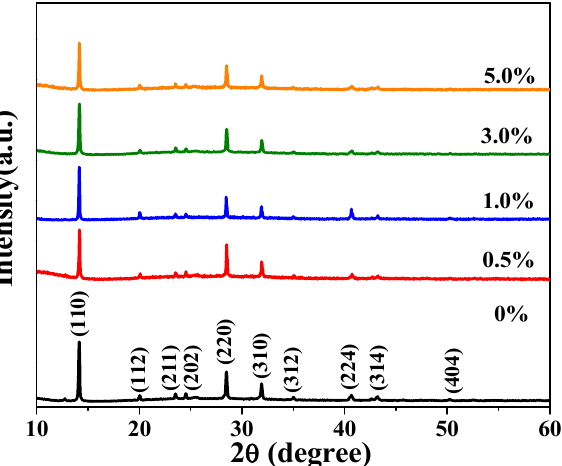
Figure 1. XRD patterns of Ag-doped perovskite films in which Ag incorporation is 0%, 0.5%, 1.0%, 3.0%, and